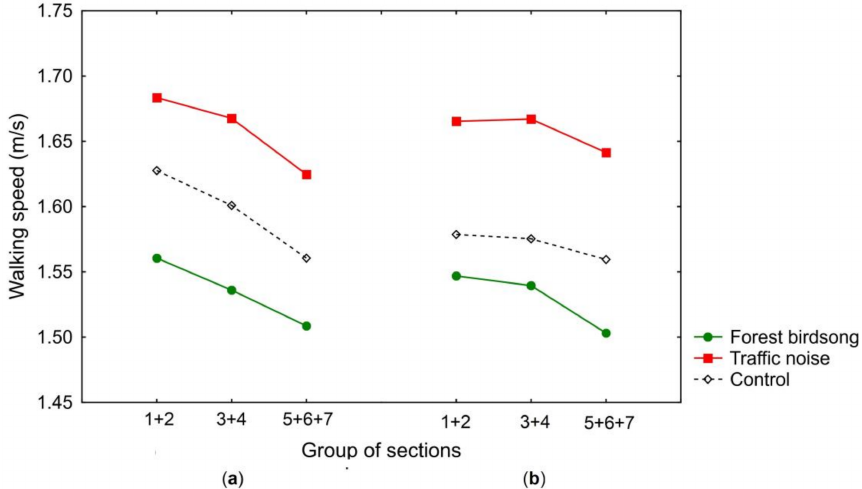
Figure 1. Average walking speeds (m/s) in particular groups of sections of the route. ( a ) The direction of the walk from section 1 to section 7. ( b ) The direction of the walk from section 7 to section 1.